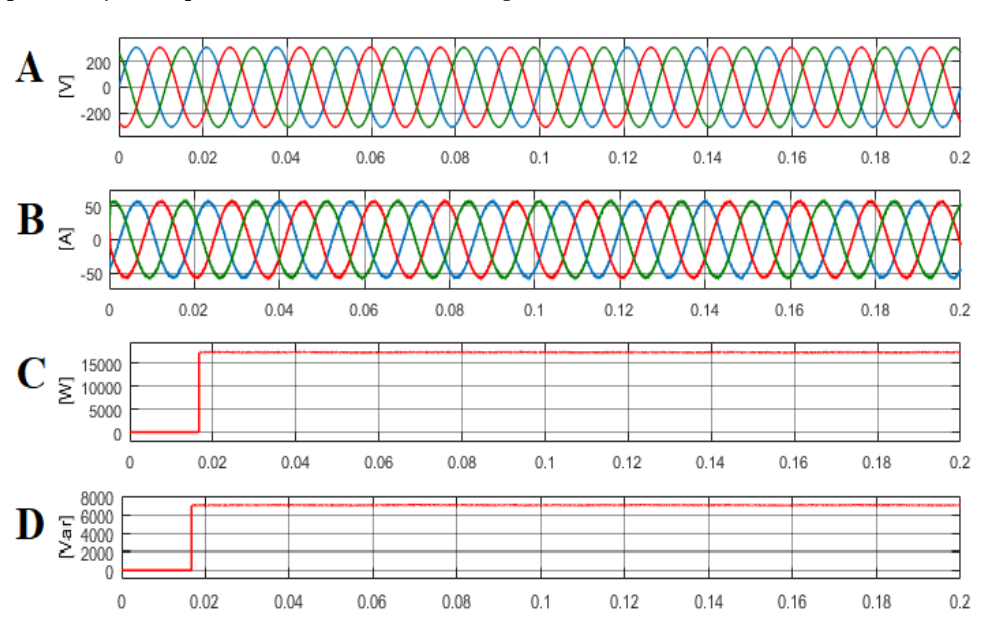
Figure 8. Representation simulation validation of the proposed control strategy with Linear Load.